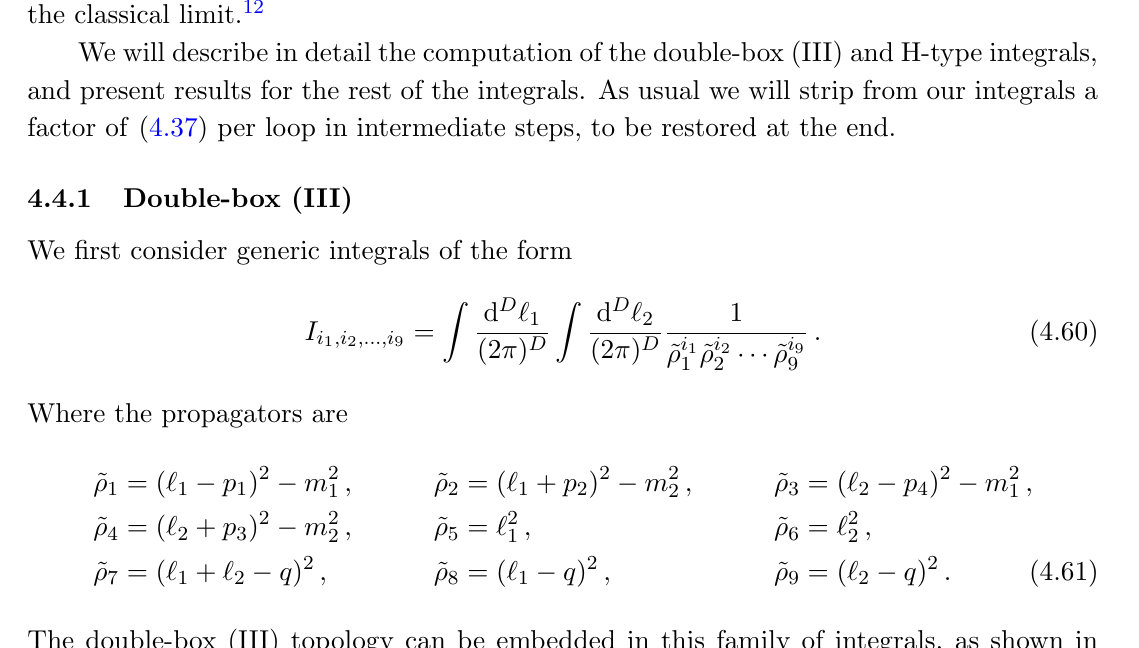
Figure 10. III topology. Indices correspond to the propagators listed in eq. (4.61). power survive the ( q 2 ) 2 suppression of the numerator, and the rest do not contribute in the classical limit.